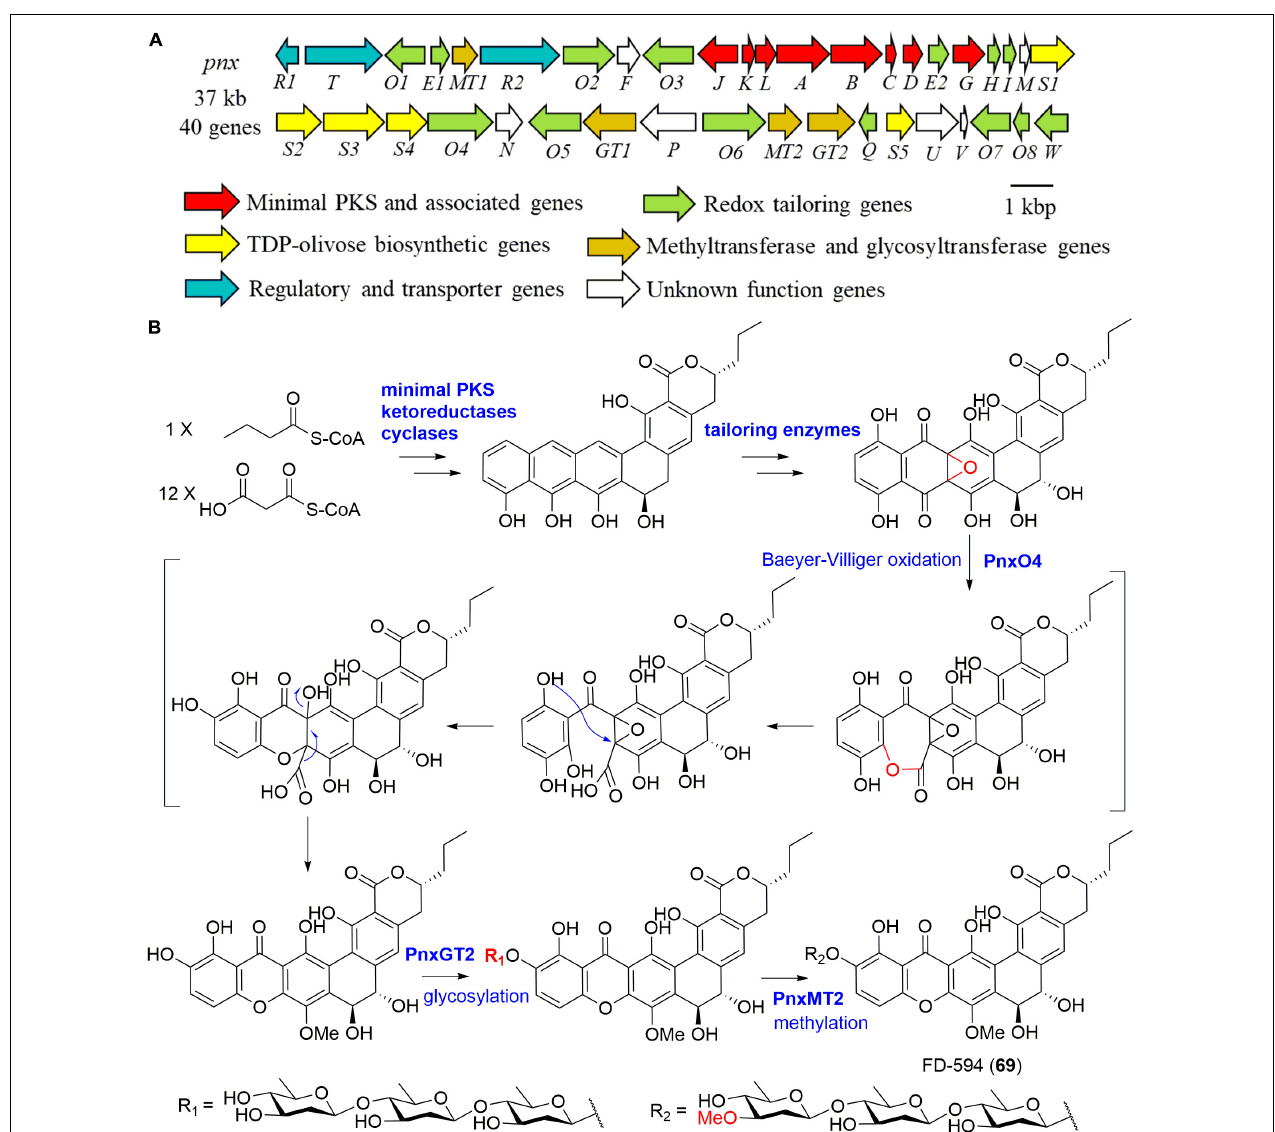
FIGURE 8 | The biosynthesis of FD-594 ( 69 ). (A) The gene cluster (pnx ) of compound 69 ; (B) the proposed biosynthetic pathway of compound 69